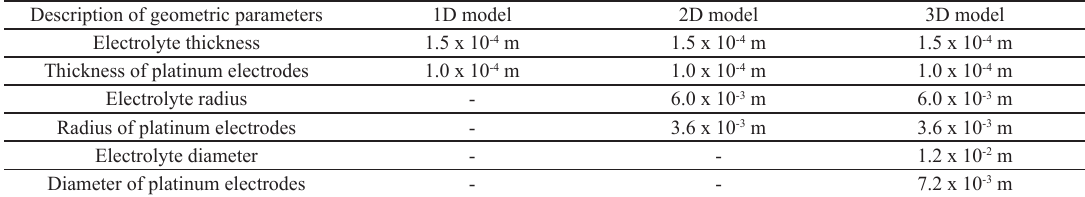
Figure 5. Planar cylindrical geometry in 3D space: a) higher perspective view; b) bottom perspective view; c) side view. Table 2. Geometric parameters used to build 1D, 2D and 3D